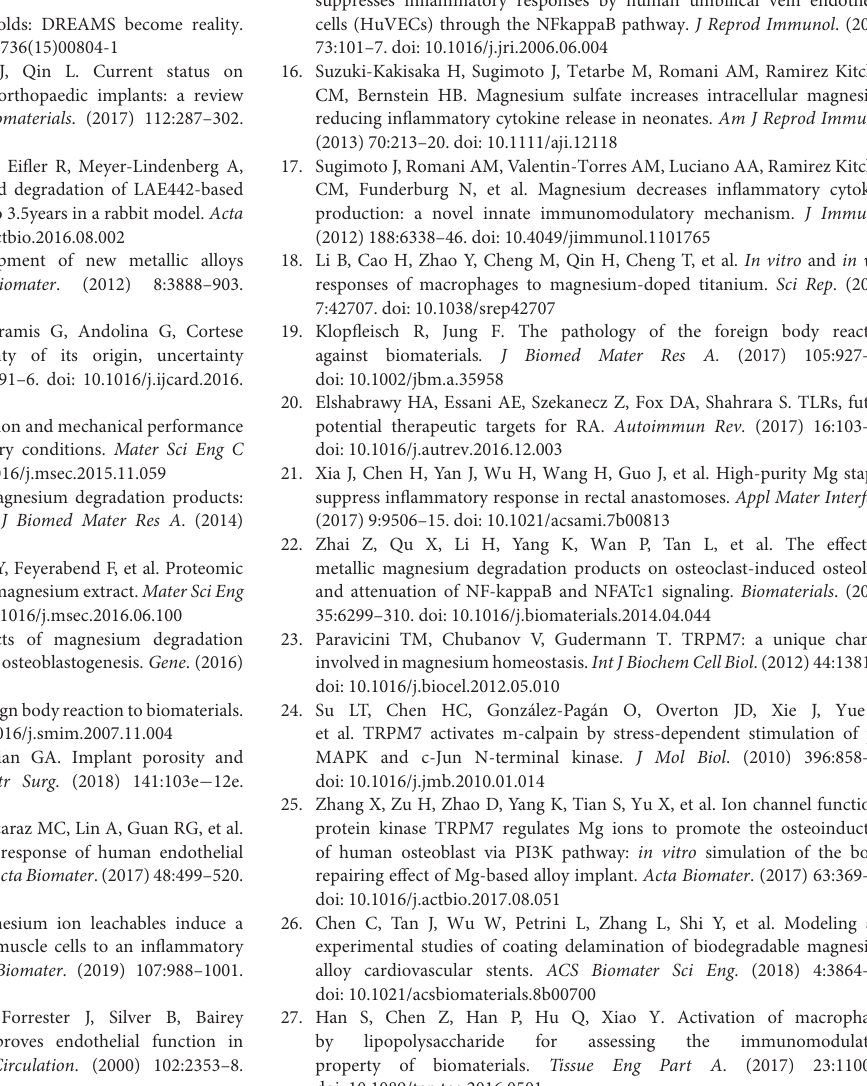
Figure S1 | Role of the intracellular magnesium from Extracts or MgCl 2 in the anti-inflammatory response. (A) THP-1 cell-derived macrophages were stimulated with LPS for 15min prior to the addition of Extracts or MgCl 2 for the indicated times. The protein expression of TNF (B) and IL-6 (C) in supernatants was measured at 24h by ELISA. The mRNA expression of TNF and IL-6 (D) was analyzed with qPCR at 6h. & P < 0.05 vs. control group. Table S1 | Primers used for real-time